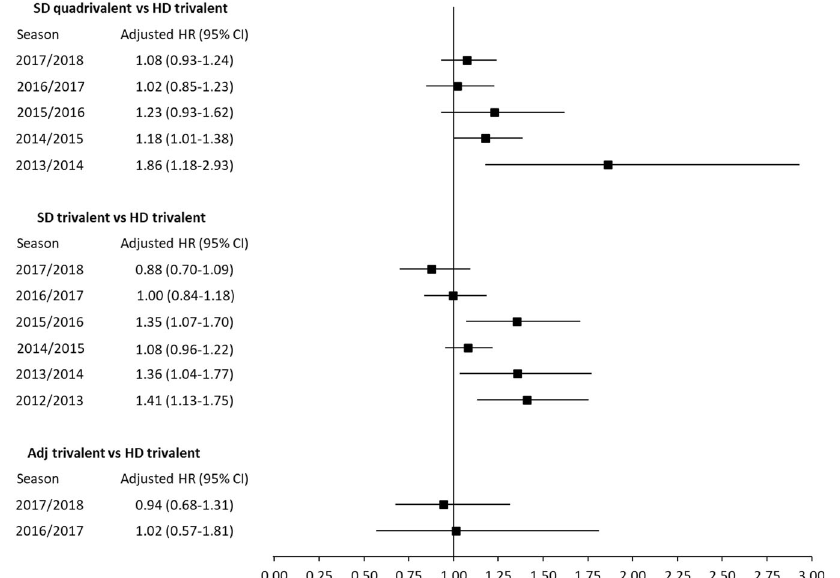
Fig. 1 Adjusted hazard ratios (HRs) for in fl uenza (hospitalization/emergency room visit). The adjusted HR point estimates and 95% con fi dence intervals are presented for each comparison and each in fl uenza season. The high-dose trivalent vaccine is used as the reference group.